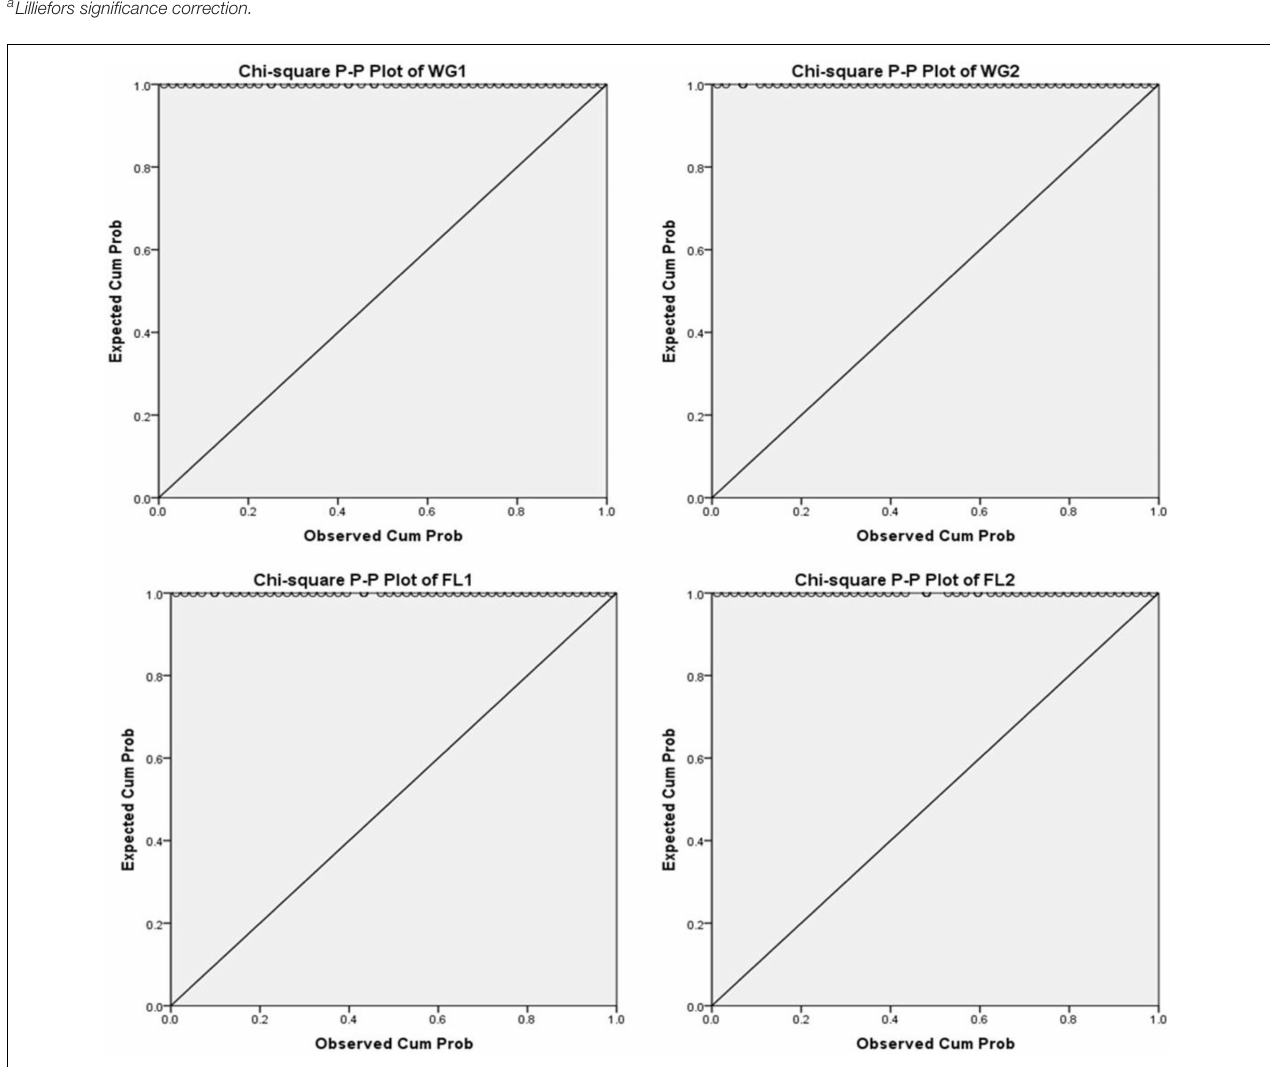
FIGURE 3 | Chi-square P-P plots of WG1, WG2, FL1, and